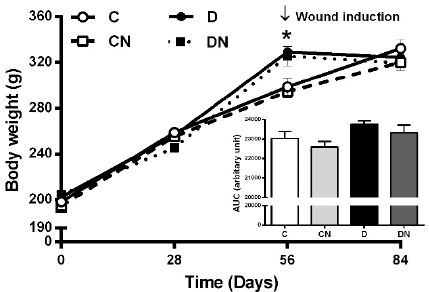
Figure 1. Changes in the body weights of rats during the study. Inset indicates the area under the curves. C, untreated control; CN, acidified nitrite-treated control; D, untreated diabetes; and DN, acidified nitrite-treated diabetes. * p < 0.001 compared to untreated control rats. Values are mean ± SEM, n =